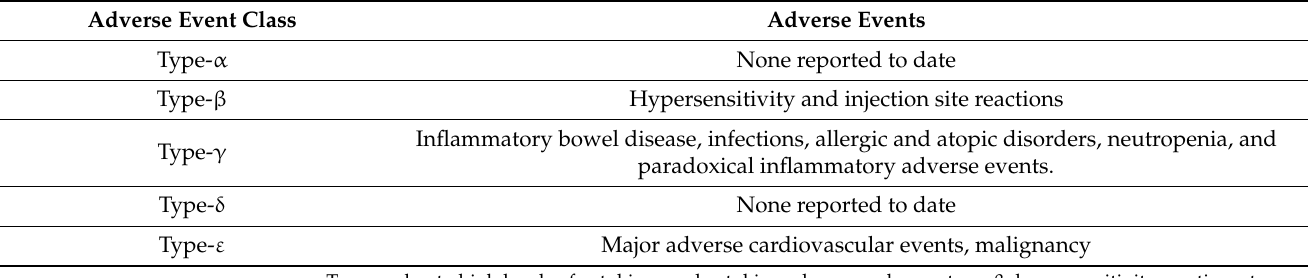
Table 1. List of adverse drug reactions to secukinumab as per Pichler’s classification [44].